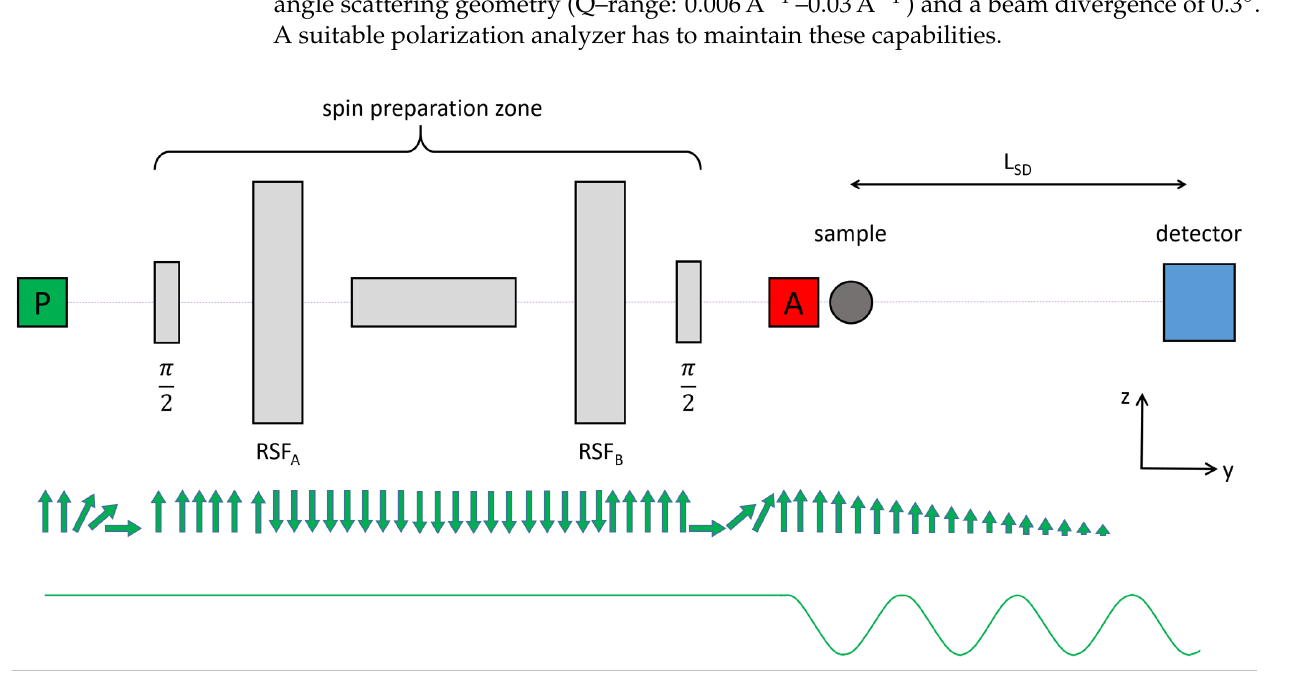
Figure 1. Schematic depiction of the MIEZE setup at the resonant neutron spin-echo spectrometer RESEDA at the Heinz Maier–Leibnitz Zentrum [2]. After passing through a velocity selector (not shown), neutrons are polarized in a double V–cavity (P). Then, they enter the spin precession zone, which is bounded by a pair of π /2–flippers. The spin precession zone consists of two resonant spin flippers (RSF A and RSF B ) and a field subtraction coil (for details, see: [3,4]). After the spin precession zone, the neutrons pass through the analyzer and sample before reaching the detector. Below the schematic the spin propagation and intensity throughout the instrument are shown. Between the two π -flippers the spin is processing in the x-z plane. The polarization decreases after the analyzer 2 due to a lack of guide field. From this point onward, the intensity is modulated sinusoidally in space and